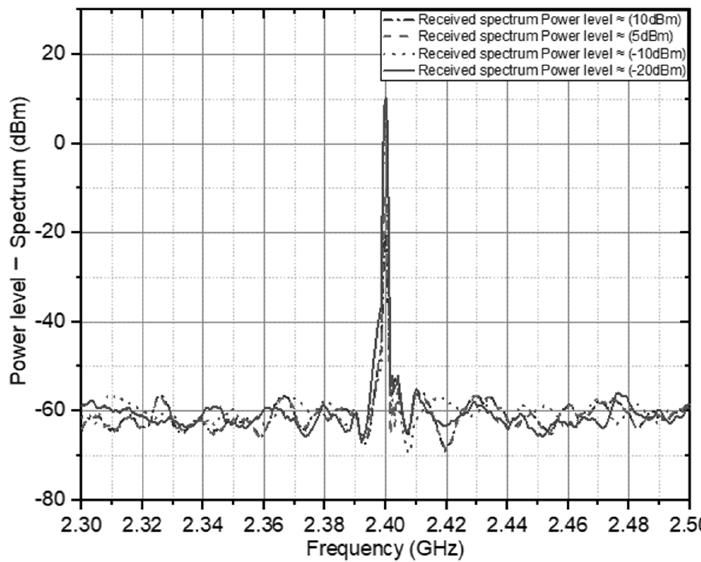
Figure 14. Spectrum graph of the signal reception level by the CP antenna.